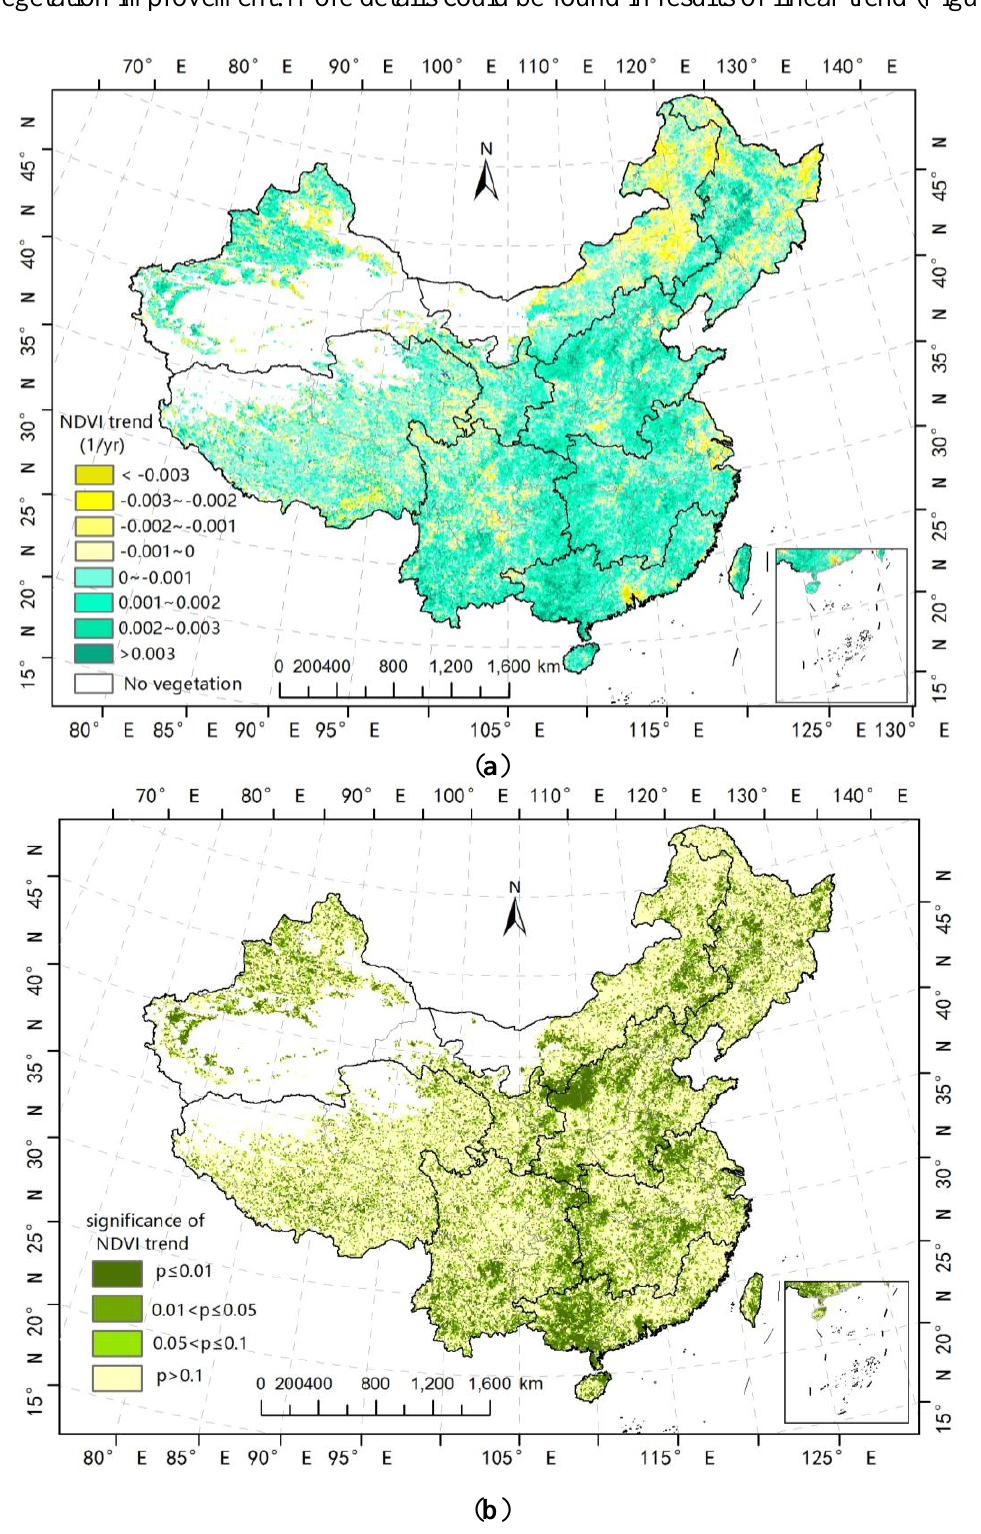
Figure 4. Growing-season NDVI trends ( a ) and their significance ( b ) from 1982 to 2011 in